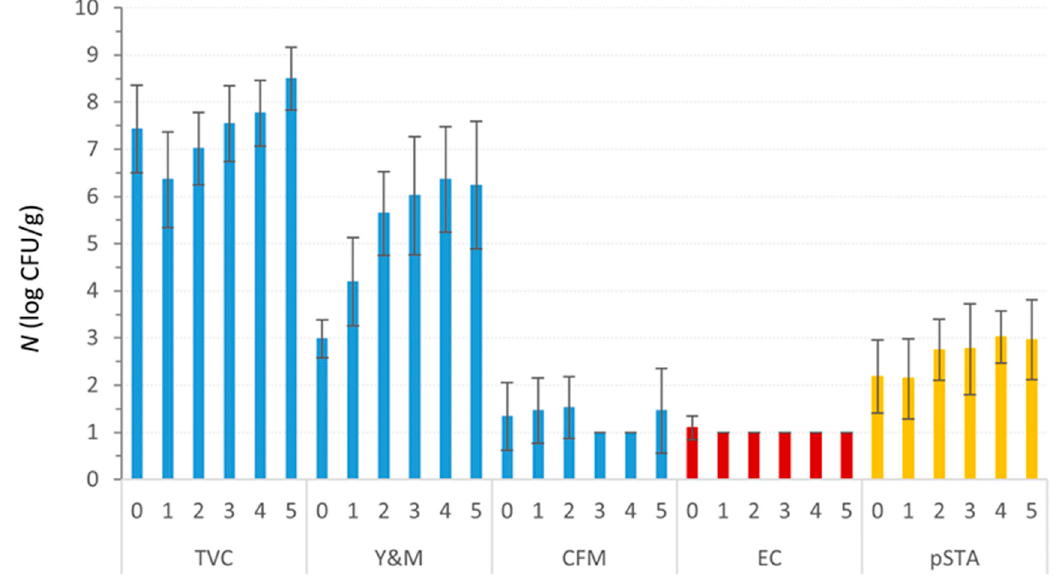
Figure 7. The microbial indicator counts in vacuum-packaged steamed and stretched cheese ( n = 13) stored at 6 °C for five weeks.